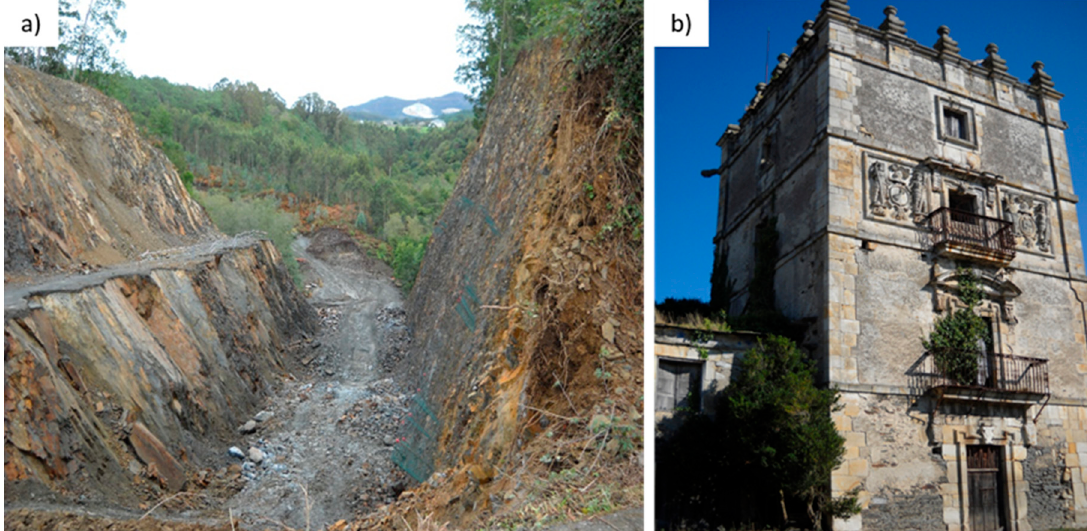
Figure 1. Case study. ( a ) Cut and cover tunnel under construction. ( b ) Historical site where the field instrumentation was placed.